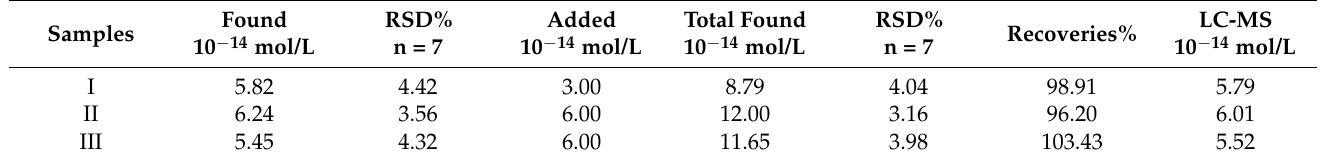
Table 1. The results of MIPs/dsDNA sensor detection of L-Pen in penicillamine tablets. Samples